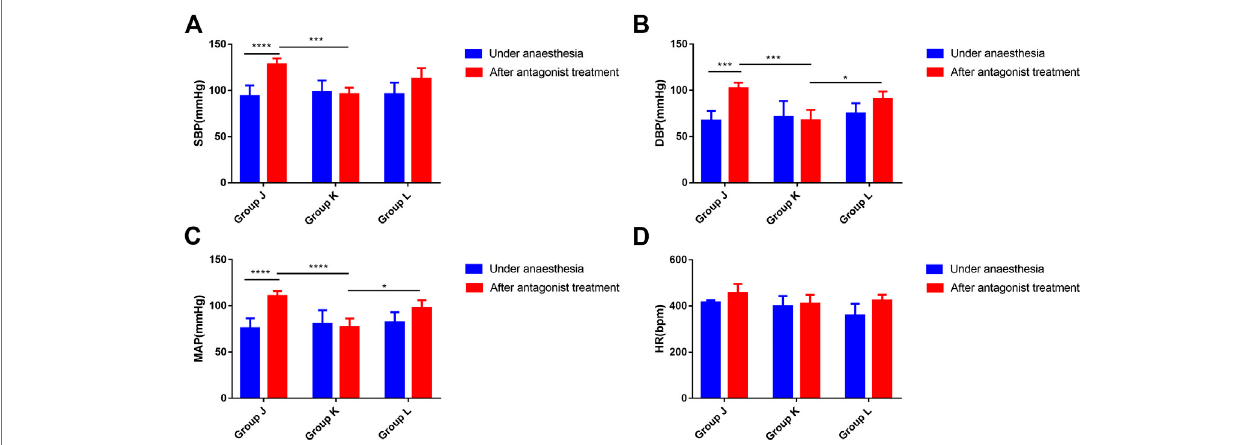
FIGURE3| Effectsonbloodpressureandheartrateinratsafterneostigmineoresmololtreatment (A) .ChangesinSBPassociatedwiththeneostigmineoresmolol treatment; (B) . Changes in DBP associated with the neostigmineor esmolol treatment; (C) . Changes in MAP associated with the neostigmine or esmolol treatment; (D) . Changesin HRassociated withthe neostigmine or esmolol treatment. Error bars represent the mean ± SD, and the comparison wasperformed usingtwo-way ANOVA. SBP, systolic blood pressure; DBP, diastolic blood pressure; MAP, mean arterial pressure; HR, heart rate. Under anesthesia, the blood pressure and heart rate under anesthesia. After antagonists, the highest blood pressure and heart rate within 40 min of using antagonists. Group J received phenylephrine and atropine simultaneously followed by intravenous saline treatment 1 min later. Groups K and L received phenylephrine and atropine simultaneously followed by 0.15 mg/kg neostigmine and 1.0 mg/kg esmolol treatment 1 min later. * p < 0.05, ** p < 0.01. N (cid:1) six.